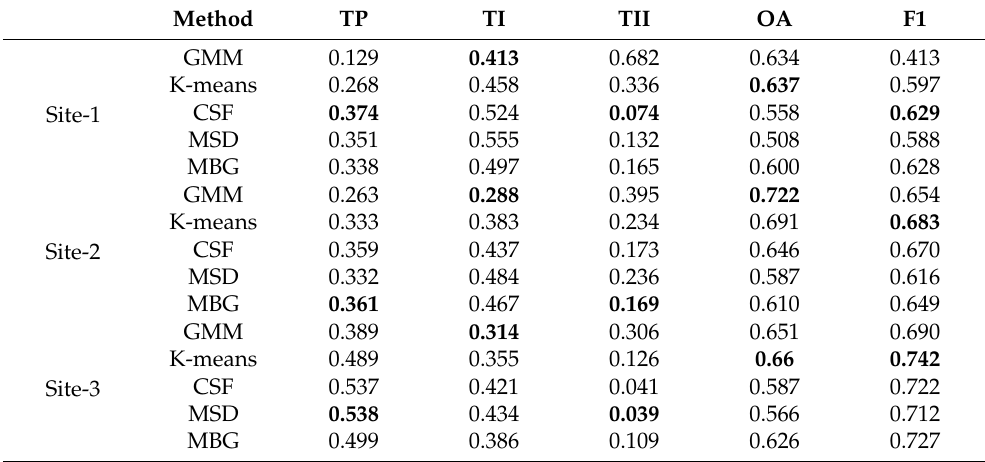
Tables 1 and 2 list detailed accuracy metrics of ground masks derived from GMM, K-means, and three ground filtering methods. Table 1 provides categorical accuracy assess- ment on ground identification by evaluating the classification accuracy of discriminating ground pixels from non-ground pixels. GMM achieves significantly lower TIs (i.e., com- mission errors, 0.288–0.413) and higher OAs (0.634–0.722) than the filtering-based methods at all study sites (Table 1). We also notice that GMM-based ground masks have larger TII errors (i.e., omission errors) than the others, especially at Site-1 (0.682) and Site-3 (0.306). This can be attributed to the uncertainty refinement and morphological erosion used for removing low-confidence and sparsely distributed pseudo-ground pixels (Figures 5 and 6).